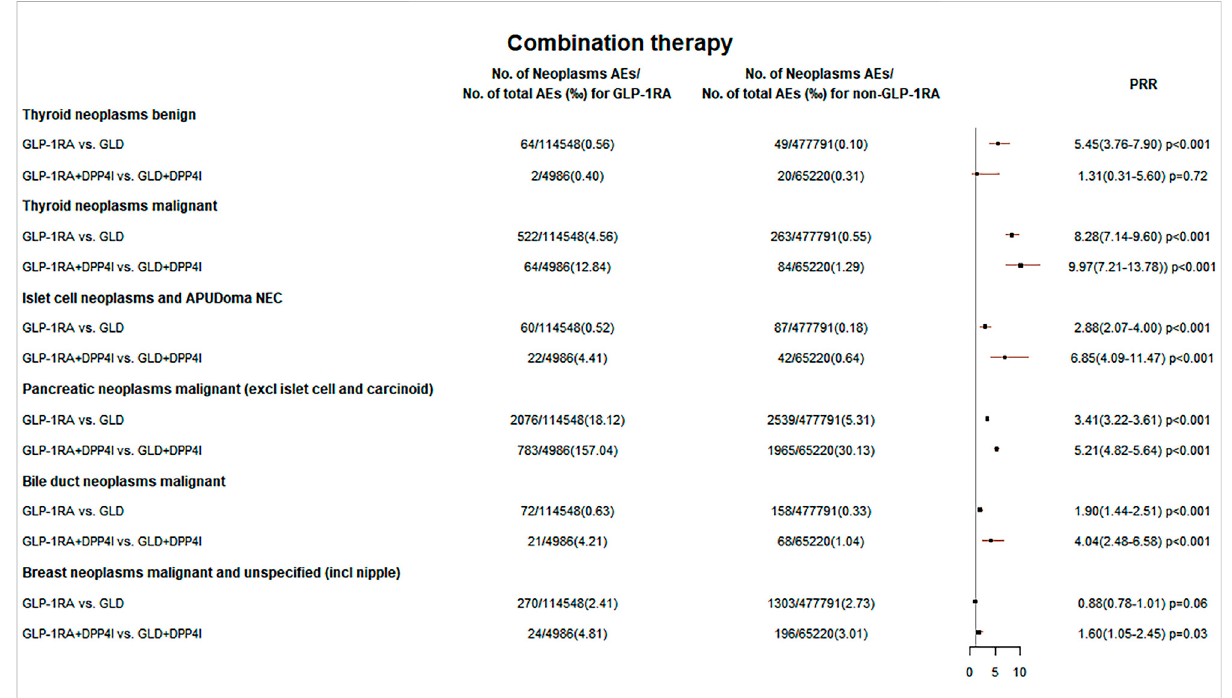
FIGURE 4 Neoplasm reporting rate of GLP-1RA and DPP4i combination therapy. The reporting rates of GLP-1RA-associated neoplasms were compared with differentcomparatorsin “ GLP-1RA vs. GLD ” : otherglucose-lowering drugs whenthe indication is limited to diabetes while excluding all tumors and in “ GLP-1RA + DPP4i vs. GLD + DPP4i ” : only the cases in combination with DPP4i on the basis of “ GLP-1RA vs. GLD ” for comparison were